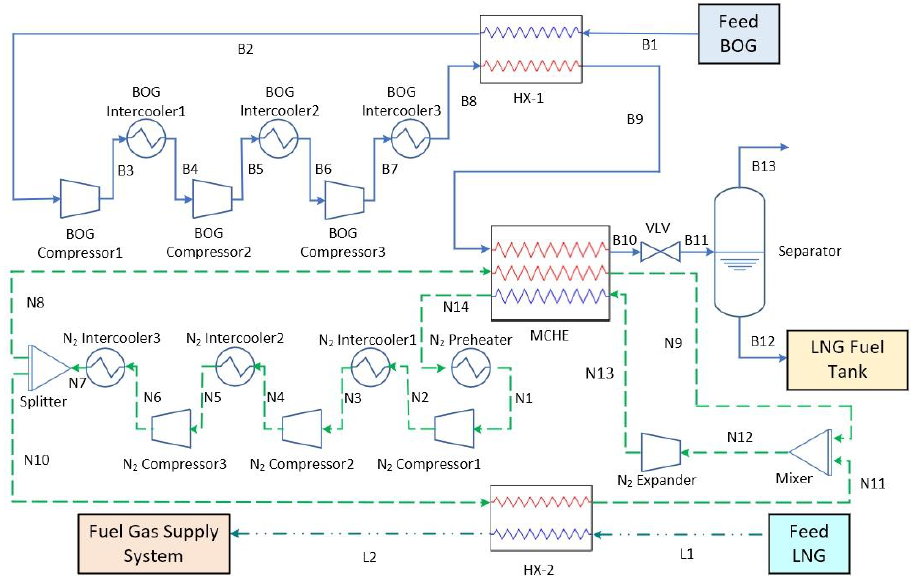
Figure 9. Schematic of the BOG re-liquefaction system for Case 2.